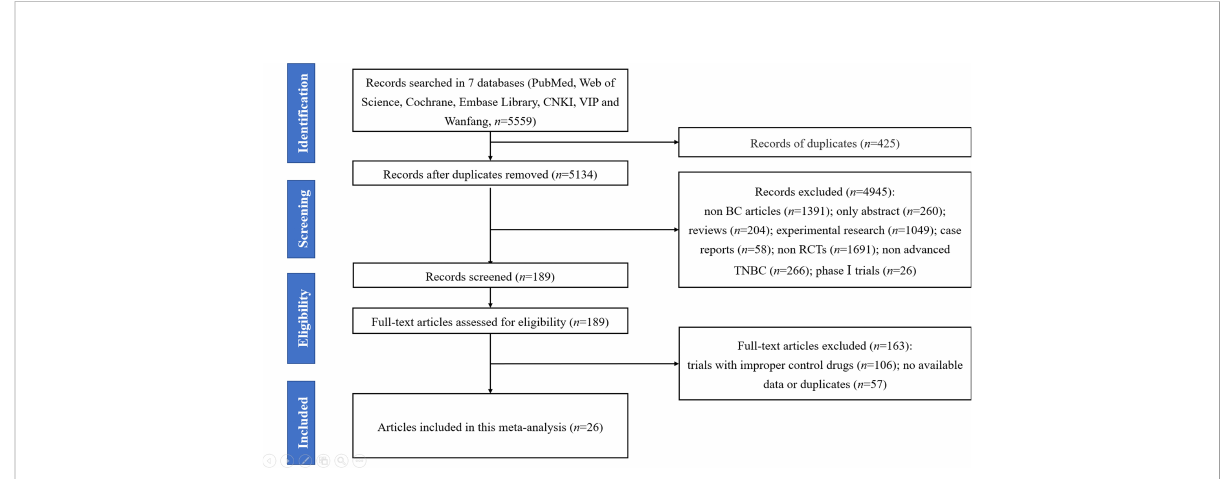
FIGURE 1 The PRISMA fl owchart summarizing the process to identify randomized controlled trials for